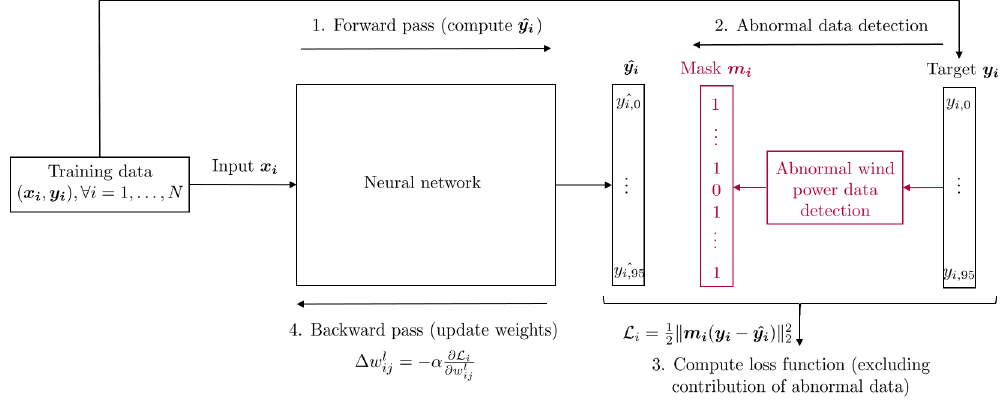
Figure 3. Strategy for training neural networks in presence of wind power abnormal